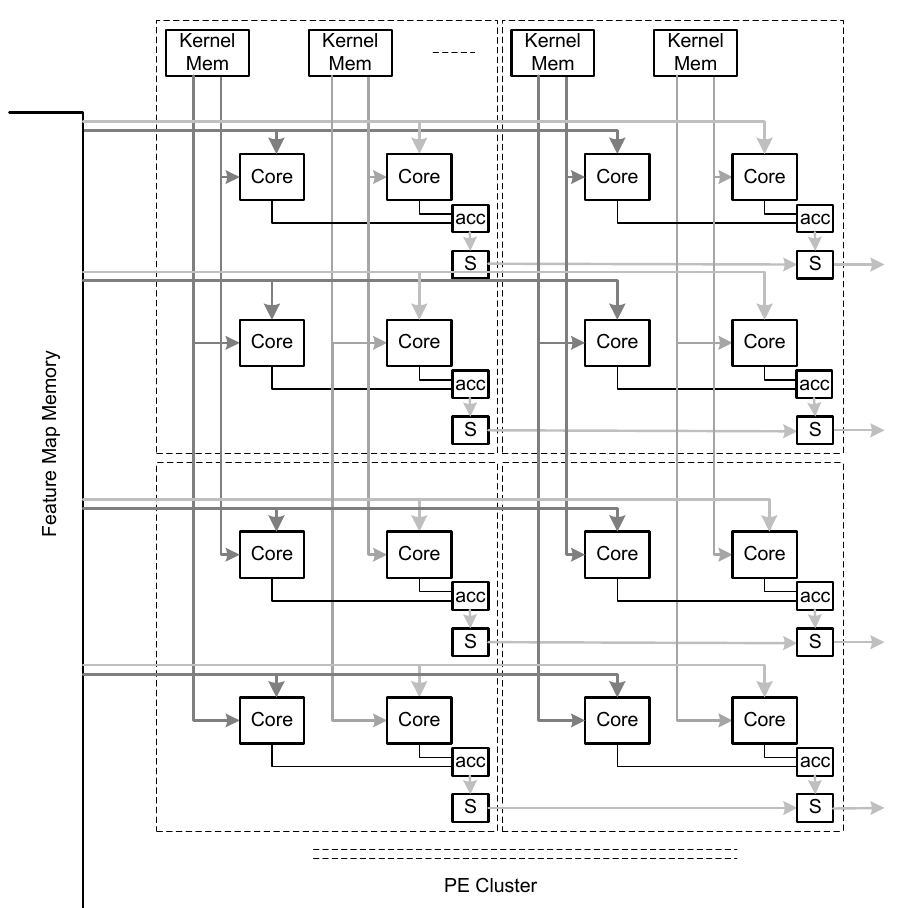
Figure 6. Architecture of the PE cluster with support for zero-skipping using dual-rate memories.